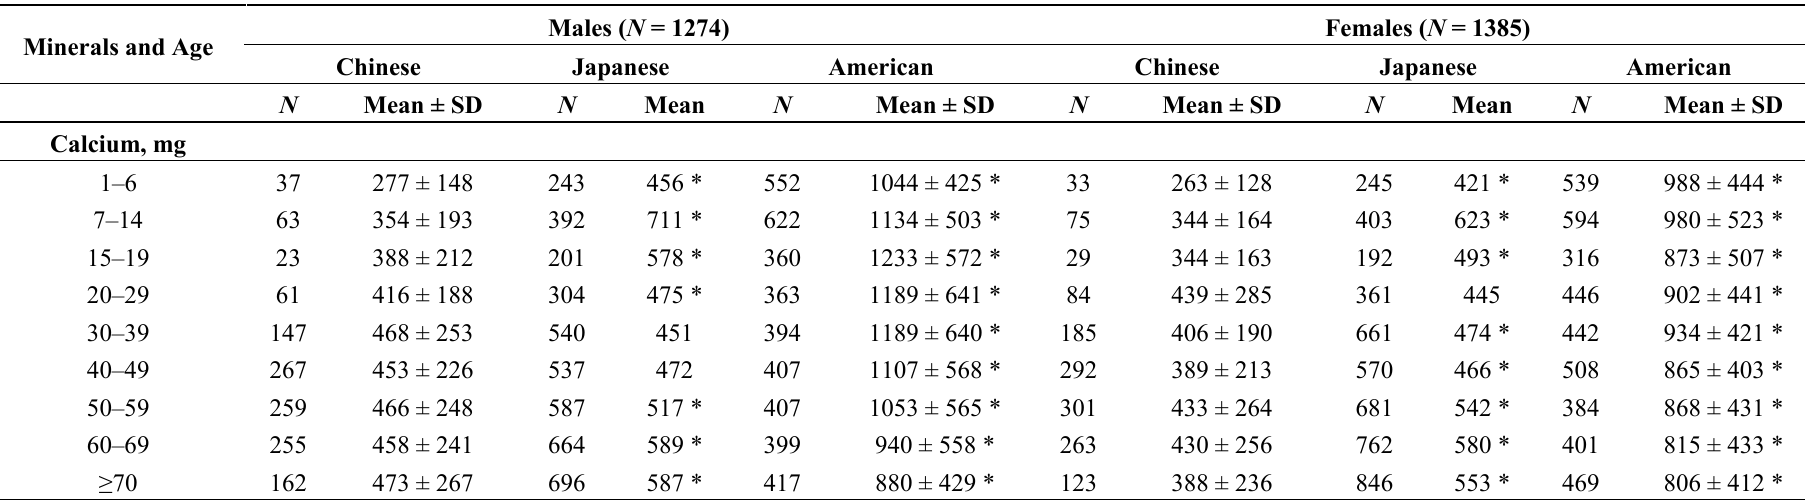
Table 3. Comparison of daily intake of minerals by age and sex in the Chinese, Japanese and American groups. Minerals and